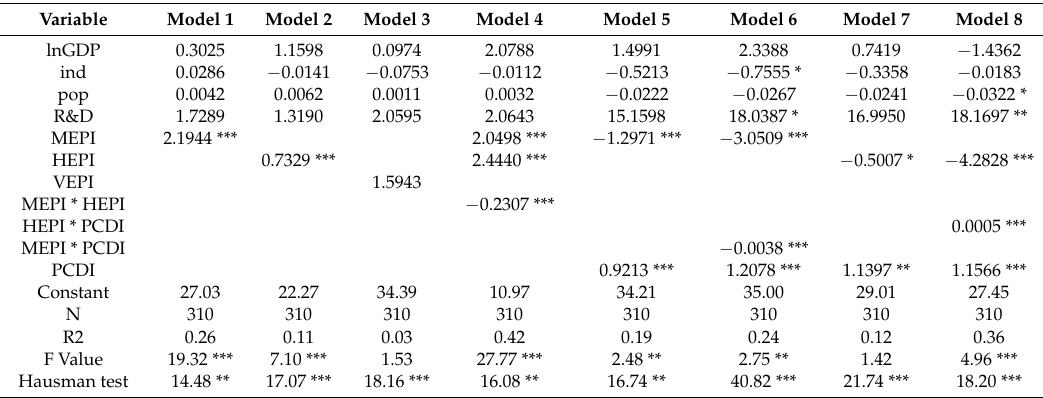
Table 5. The regression model.